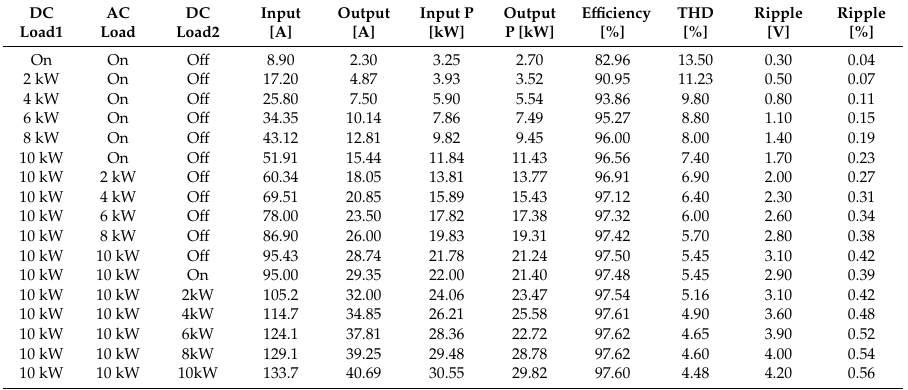
Table 5. Results of the AC / DC power converter performance test.